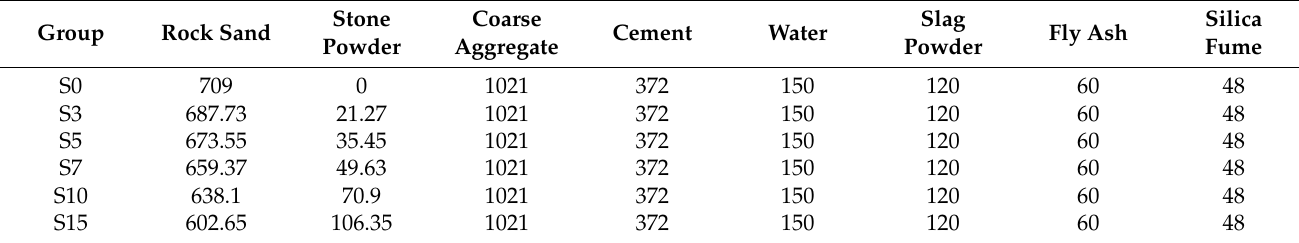
Table 5. Mix ratio of C80 concrete (kg/m 3